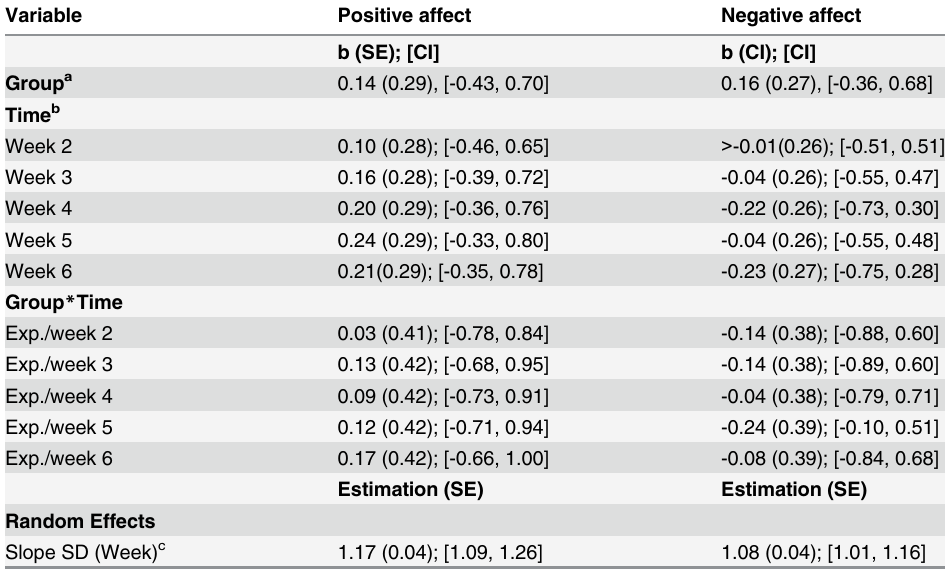
Table 3. Results of mixed effects models: Change in affect during intervention